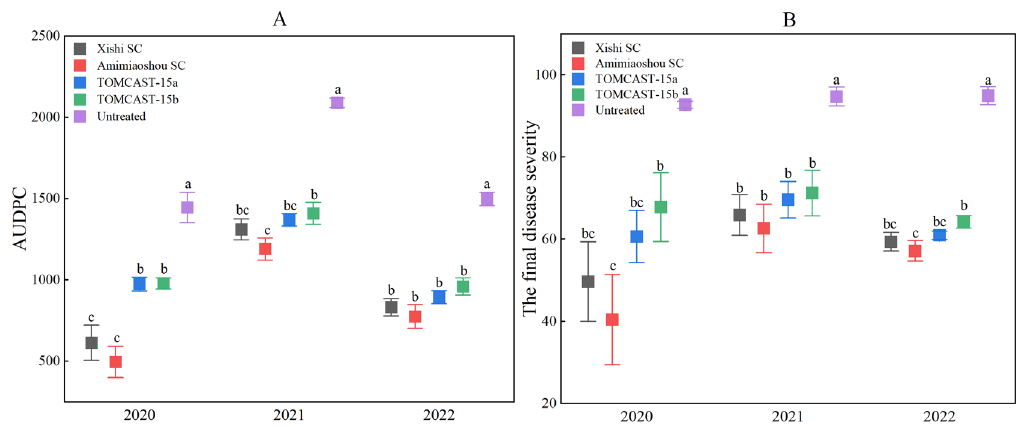
Figure 3. Comparison of area under the disease progression curve (AUDPC) ( A ) and the final disease severity ( B ) from 2020 to 2022. Each point represents the mean of five replicates, and the error bars associated with each point represent the standard error. The same letter on each point indicates no significant difference between different treatments in the same year, and vice versa, according to LSD’s honestly significant difference ( p < 0.05).